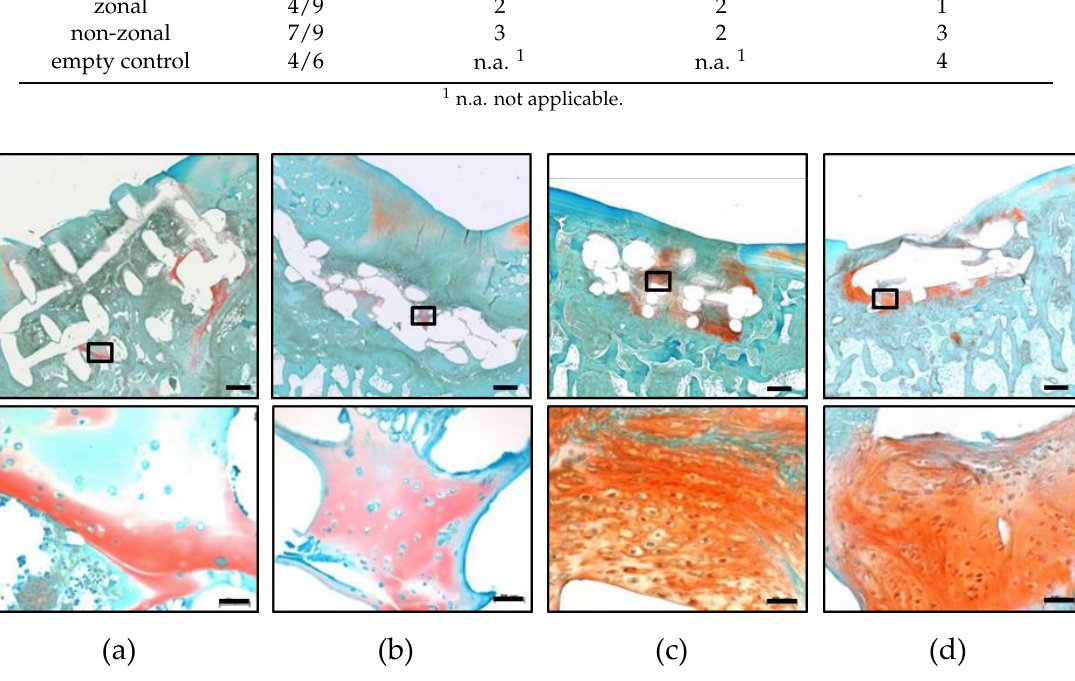
Figure 5. Cell differentiation within the PCL enforcement inside and outside of persisting hydrogel. Best results per group of cells in Safranin-O-positive hydrogel fragments ( a , b ) and Safranin-O-positive areas within PCL enforcement with differentiated cells ( c , d ) are shown. Rectangle: area of magnification on the bottom. Safranin O/Fast Green staining. Scale bar: 500 µm (overview, top), 50 µm (magnification, bottom).